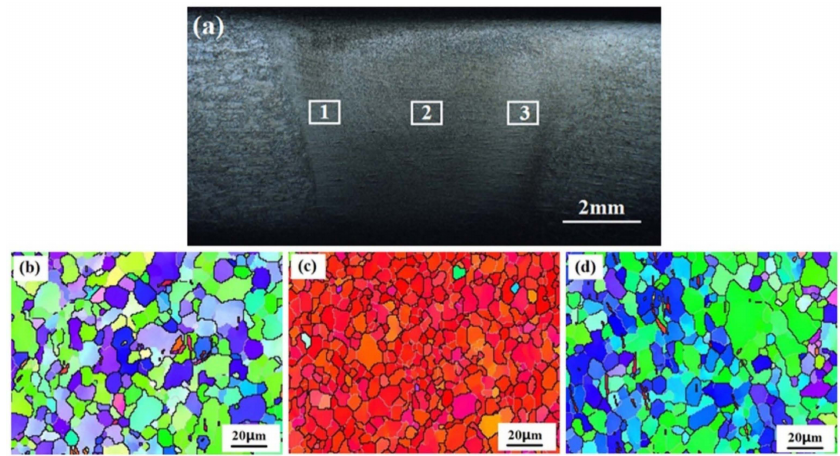
Figure 3. The whole morphology ( a ) and microstructure characteristics in di ff erent zones ( b ) position 1 ( c ) position 2 ( d ) position 3 of the FSWed AZ31 Mg alloy joint. (2–15 ◦ and > 15 ◦ grain boundary were marked by white and black, respectively).